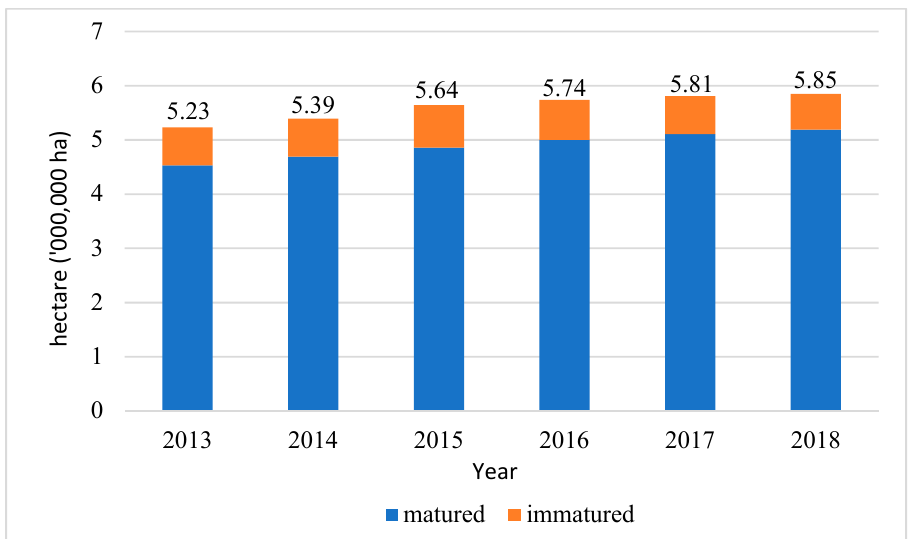
Figure 1. Oil palm planted area in Malaysia from 2013 to 2018. The figure above was adapted with permission from the cited reference [21].